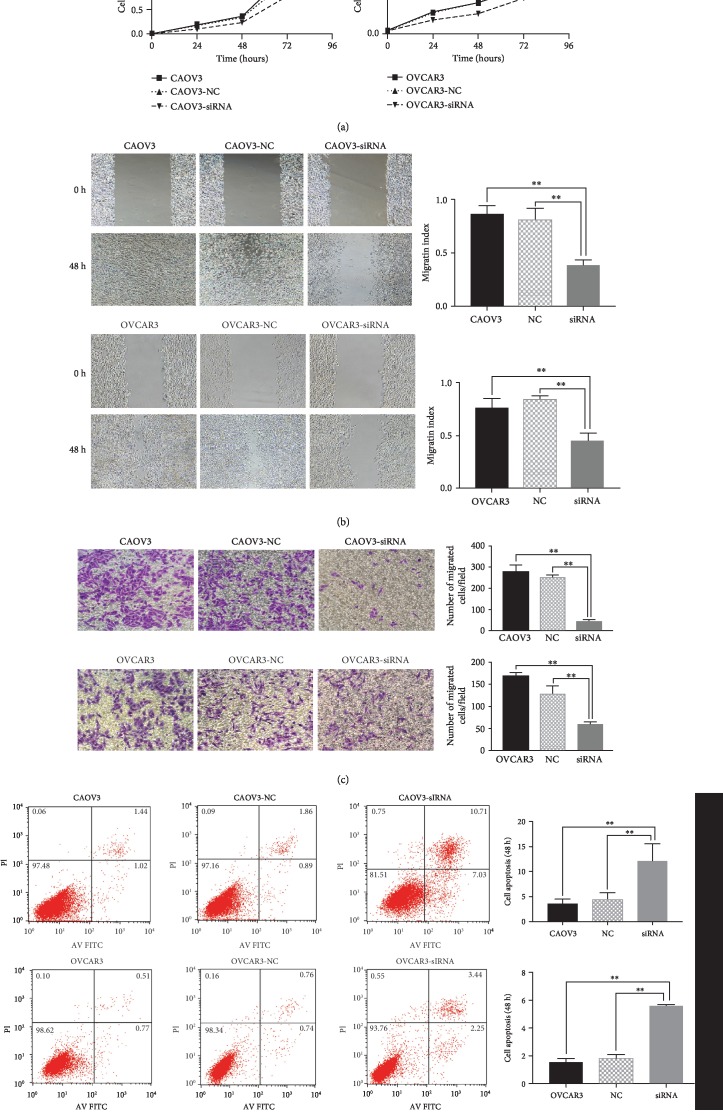
Effects of BMPER specific siRNA transfection on proliferation, migration, invasion, and apoptosis of ovarian cancer cell lines CAOV3 and OVCAR3. Changes in the above malignant behaviors of ovarian cancer cells were detected by MTT, wound healing, Transwell, and flow cytometry assays, respectively. Results showed the inhibition of BMPER with siRNA transfection reduced the proliferation (a), migration (b), invasion (c), and promoted apoptosis (d) of CAOV3 and OVCAR3 cells compared with the control groups. ∗P < 0.05, ∗∗P < 0.01.